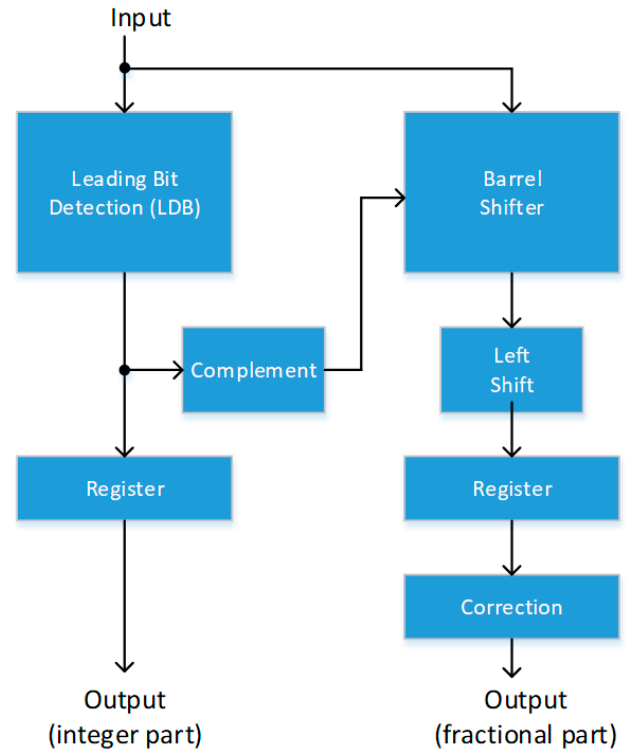
Figure 11. Block diagram of the architecture design for the log 2 approximation module.